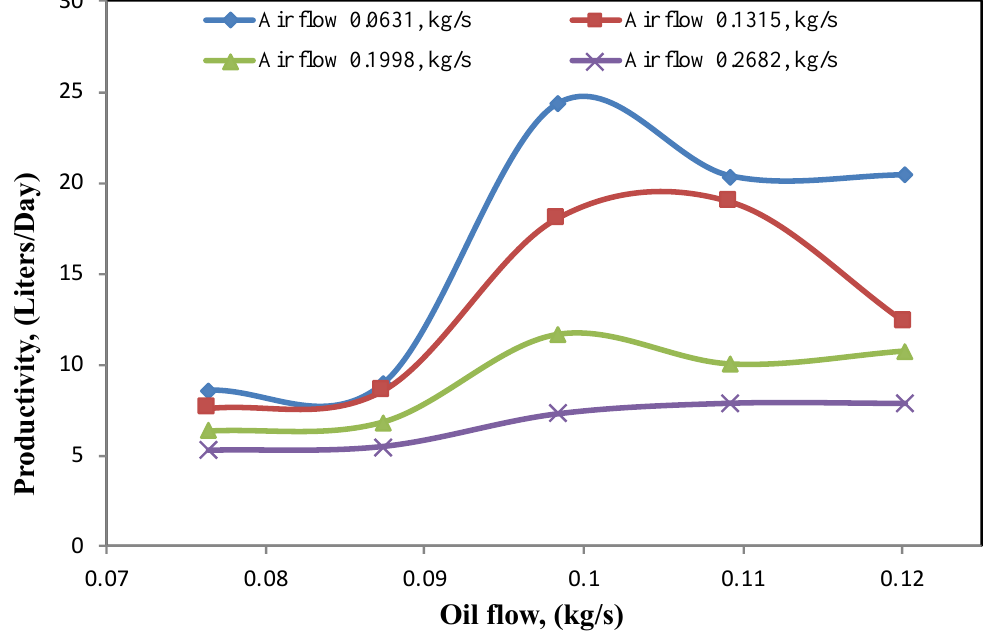
Figure 10. The productivity of the system at different air and oil flow rates.